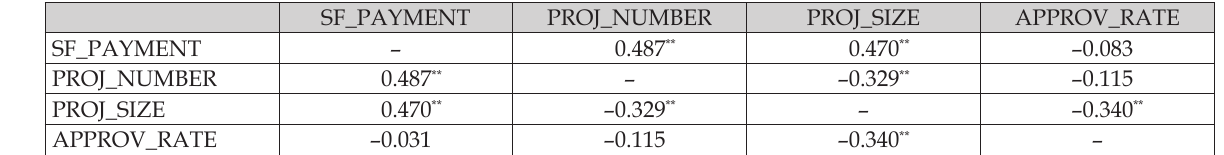
Table 6. Pearson correlation